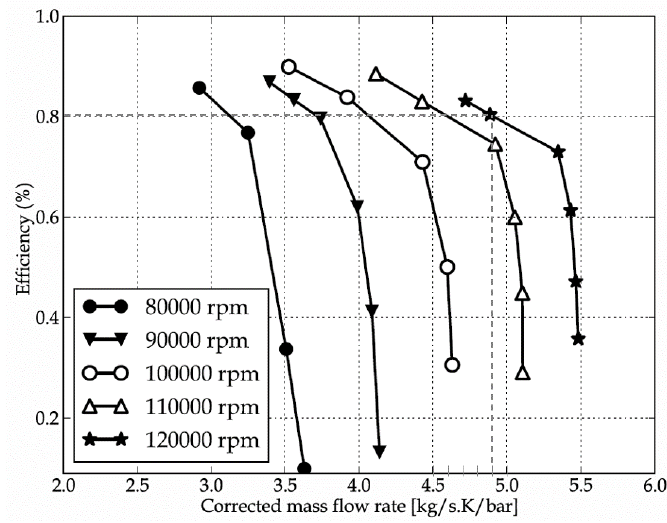
ffi ciency vs Corrected mass Figure 5. BMT compressor map (Efficiency vs Corrected mass flow). Figure 5. BMT compressor map (E Figure 5. BMT compressor map (Efficiency vs Corrected mass flow).